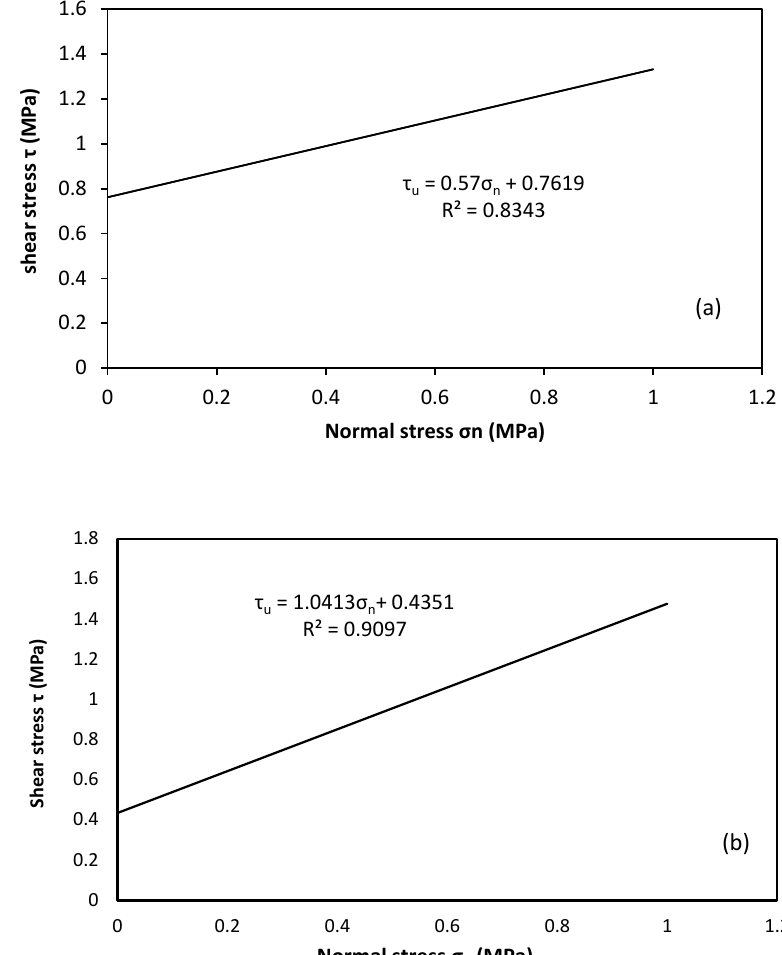
Figure 6. Maximum shear strength versus pre-compression level for non-strengthened shear triplet test: ( a ) STA, ( b ) STB.